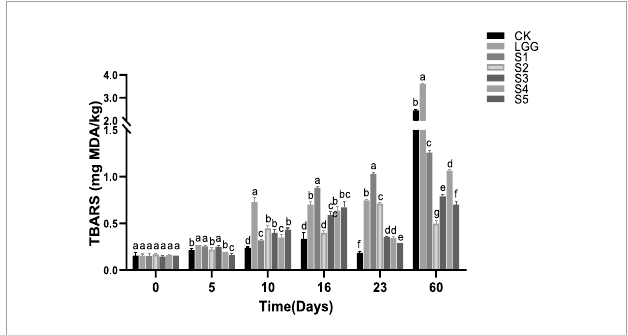
FIGURE7 Evolution of thiobarbituric acid reactive substances (TBARS) value during the ripening of the different samples of sausage. Different letters indicate that there are significant differences in TBARS values between different groups at the same time ( p <